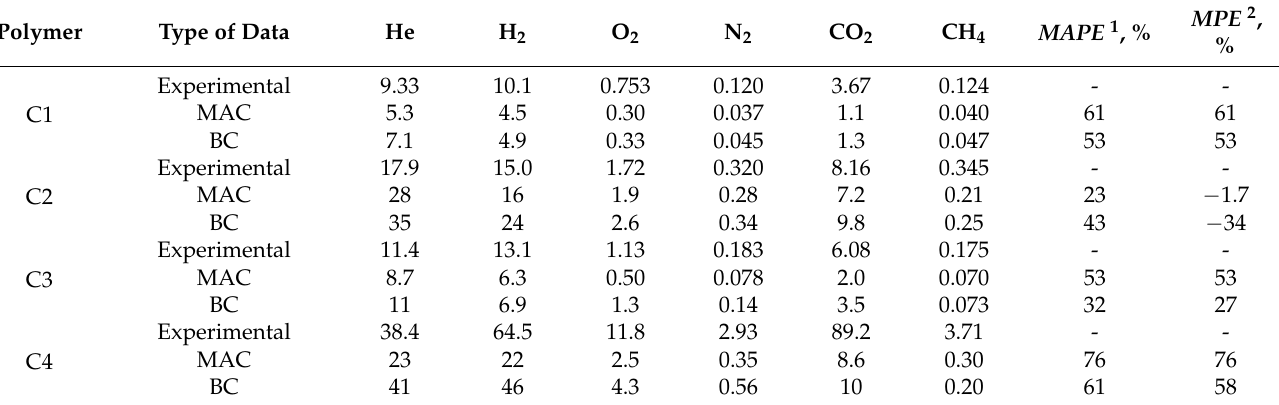
Table 7. Experimental gas permeability coefficients P (Barrer) for synthesized polymers at 35 ◦ C and predicted data for the same